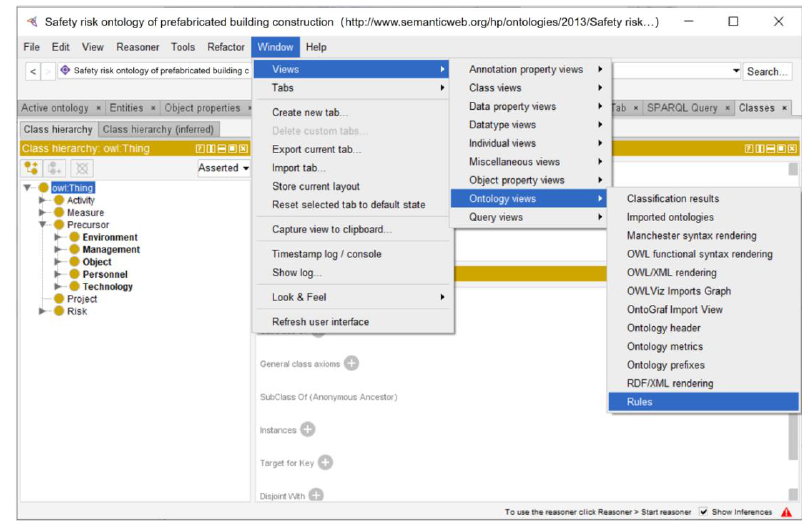
Figure 5. SWRL rule entry in the Protégé interface.